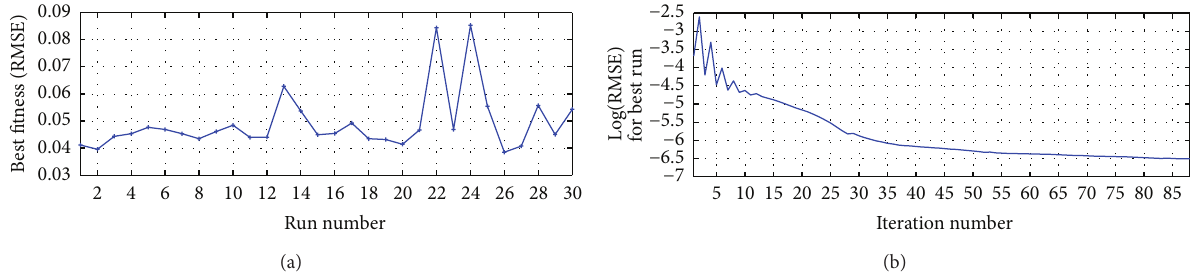
Figure 15: MA-ANN-RPROP(9,10,1): (a) run versus fitness for 85 iterations and (b) iterations number for the best run.